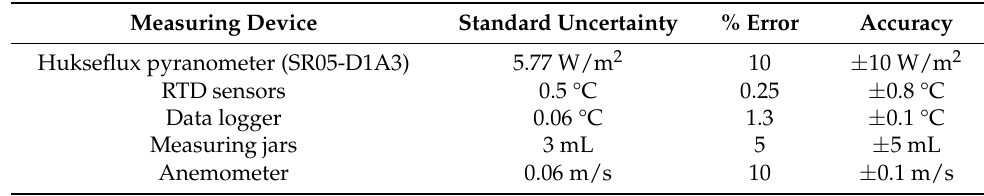
Table 1. Measuring instruments